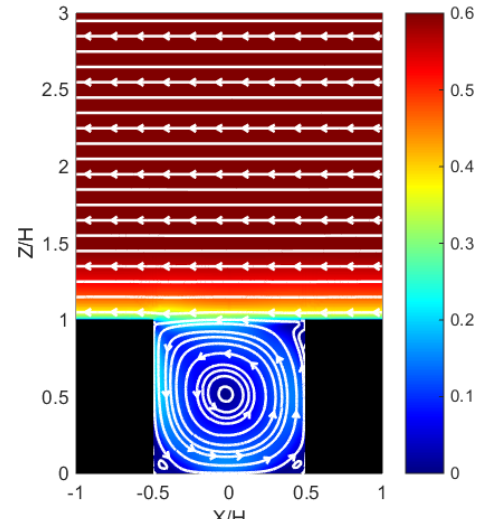
Fig. 7. Mean field of the non-dimensional intensity of the velocity, U/U 0 , for flat roof (U 0 is the free-stream velocity); the flow moves from the right to the left; the white lines are streamlines.